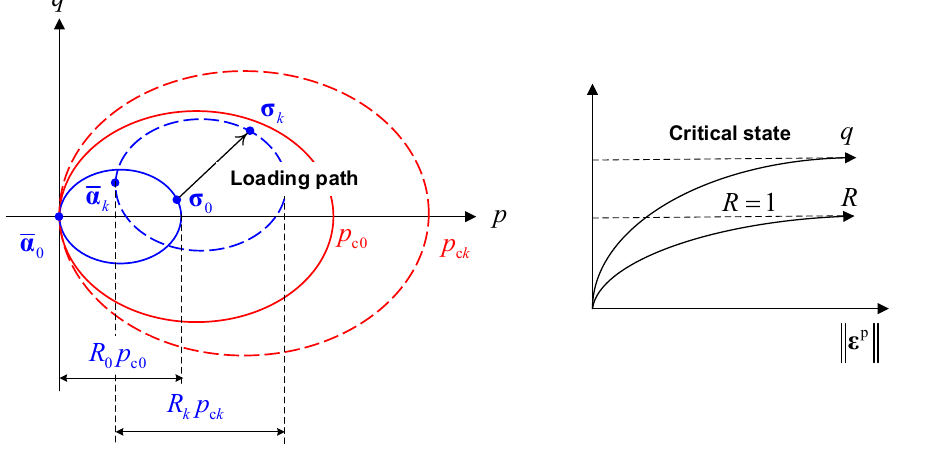
Figure 2. Schematic representation of the evolution law of subloading